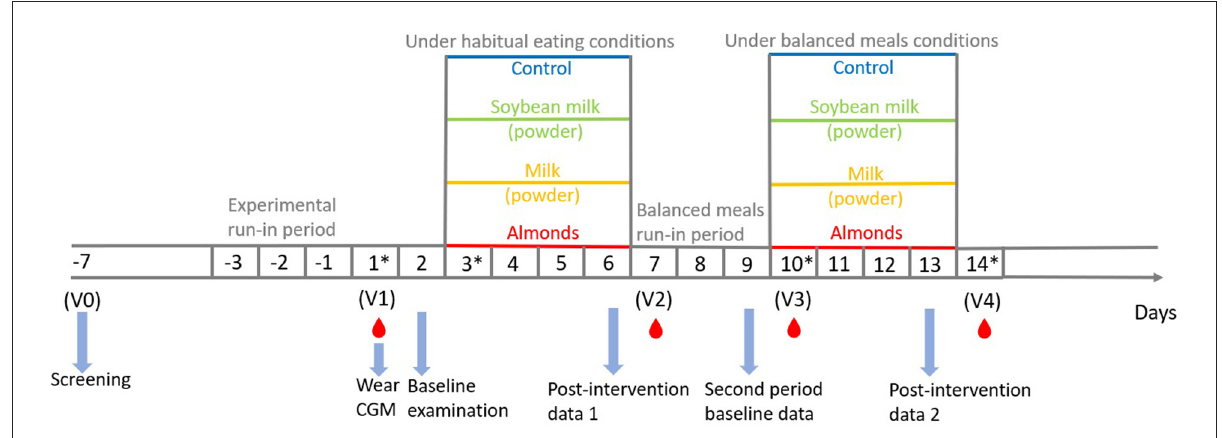
FIGURE1 Study design. * Data from CGM are excluded from the final analysis. CGM, continuous glucose